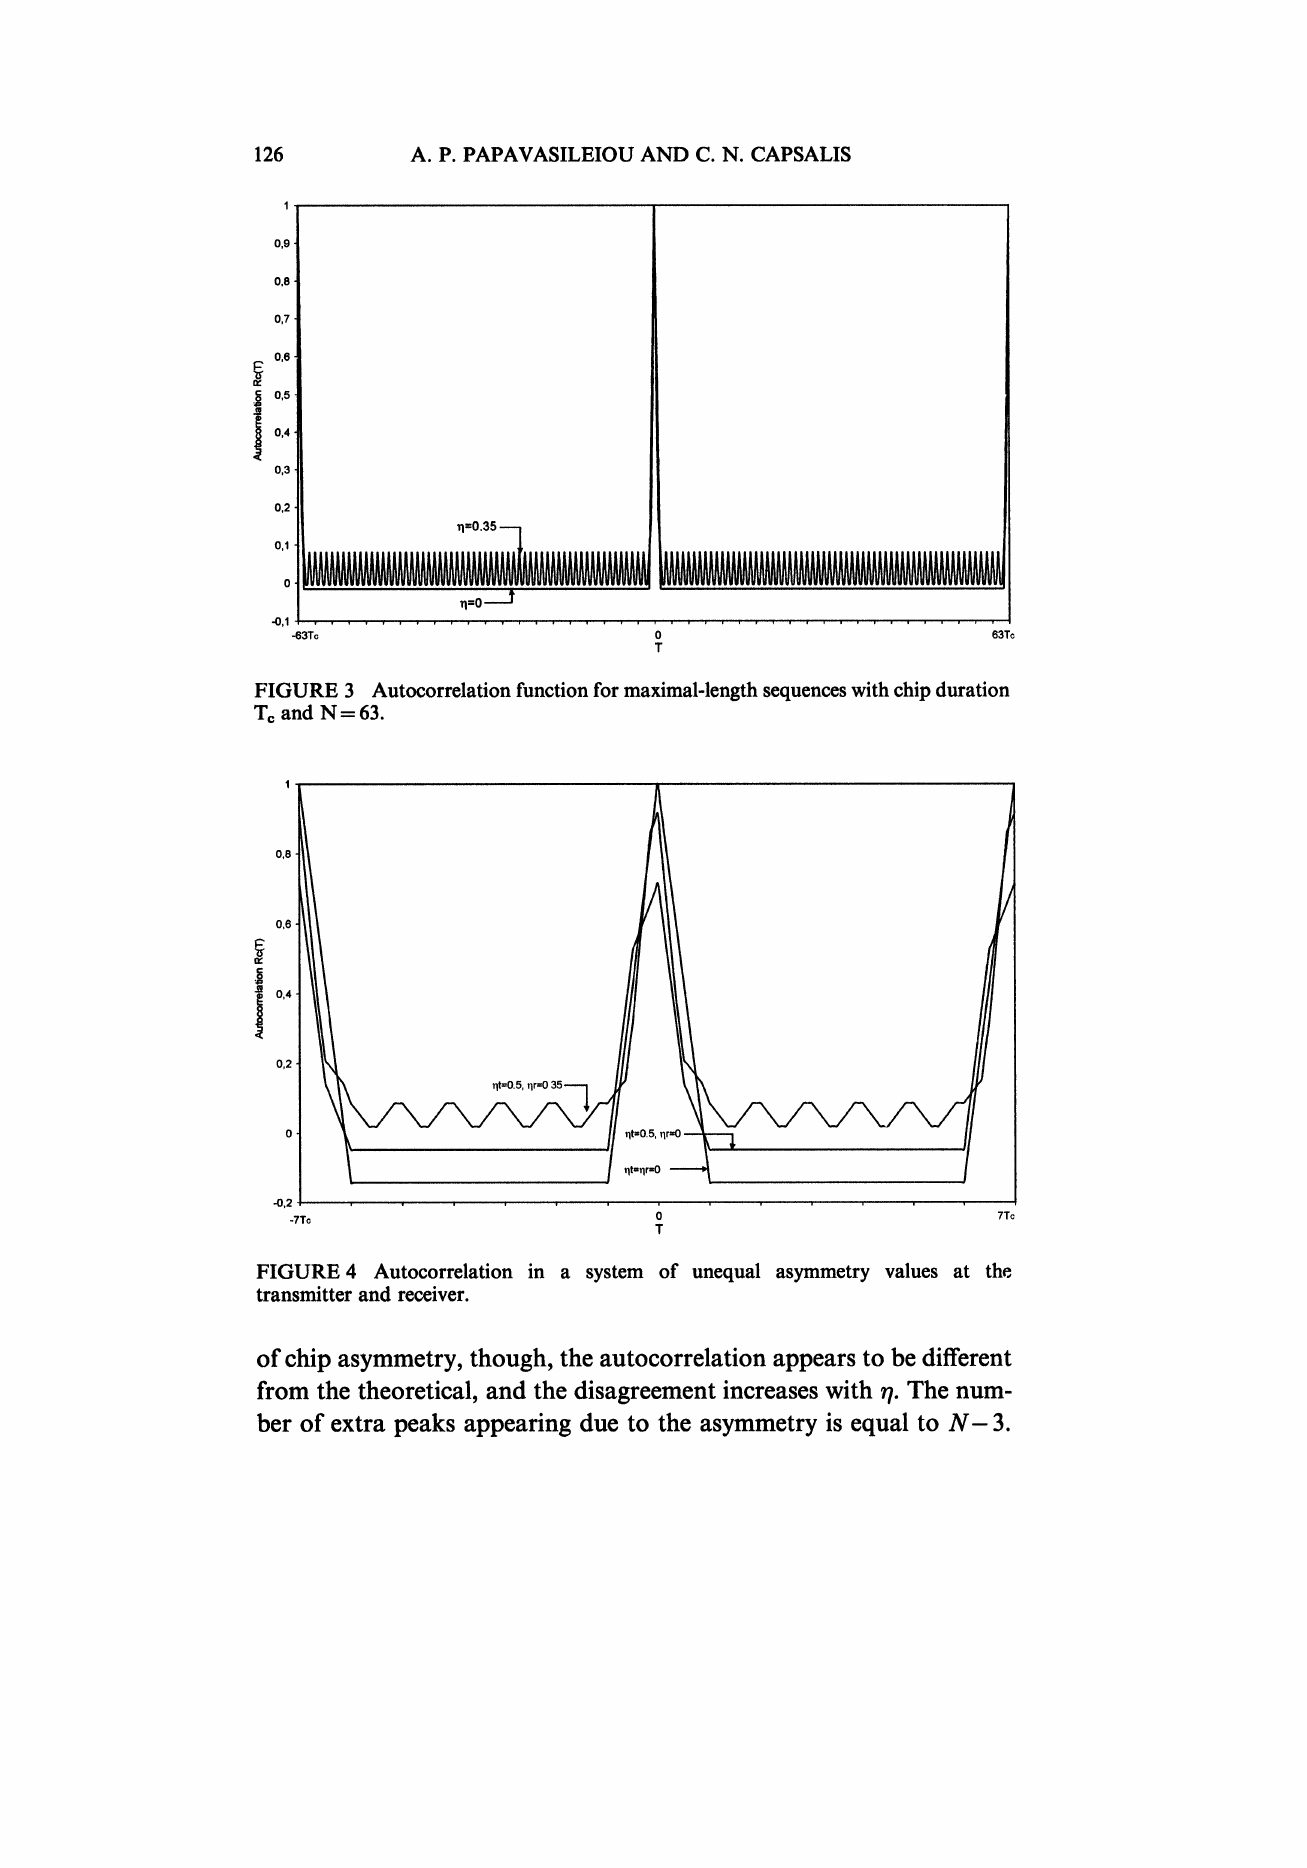
FIGURE 3 Autocorrelation function for maximal-length sequences with chip duration Tc and N 63.